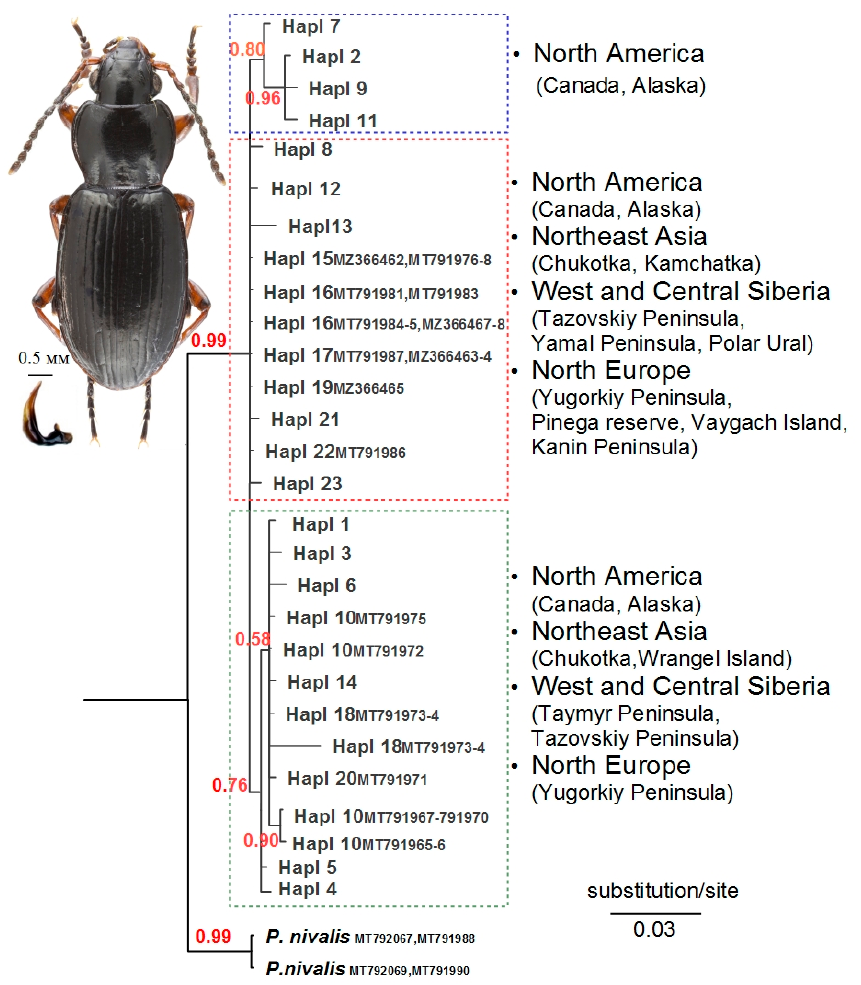
Figure 2. The majority-rule consensus phylogenetic tree of Pterostichus brevicornis brevicornis recovered from Bayesian inference analysis based on the combined mitochondrial and nuclear sequence dataset. Haplotype codes are indicated in Supplementary Materials Table S1 (on tree plot haplotype numbers according to COI marker). Numbers near branches indicate the Bayesian posterior probability (BPP). Photo by Zubrii N.A (male specimen; Russia, Yugorskiy Peninsula, near Amderma settlement).